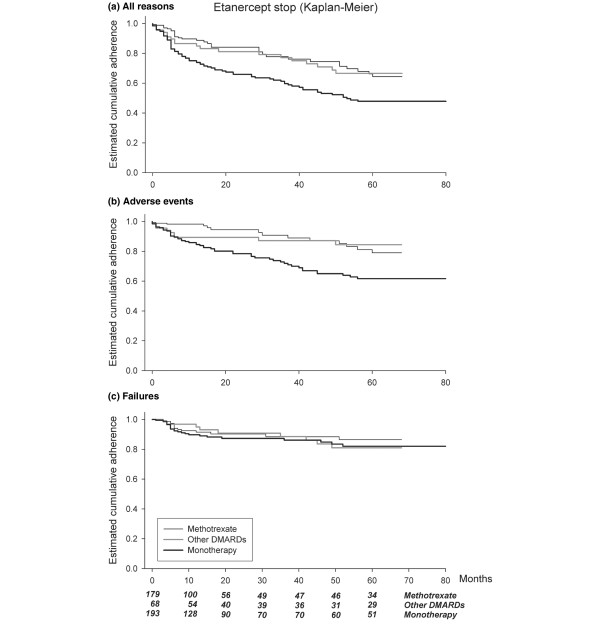
Adherence to therapy for patients treated with etanercept. The level of adherence to therapy is shown as the fraction (between 1 and 0) of patients remaining on therapy during the observation period. Withdrawal due to any reason (a), adverse events (b), or failure to treatment (c) is presented separately. The number of patients under observation at each time point is listed at the bottom of the figure. DMARD, disease-modifying antirheumatic drug.